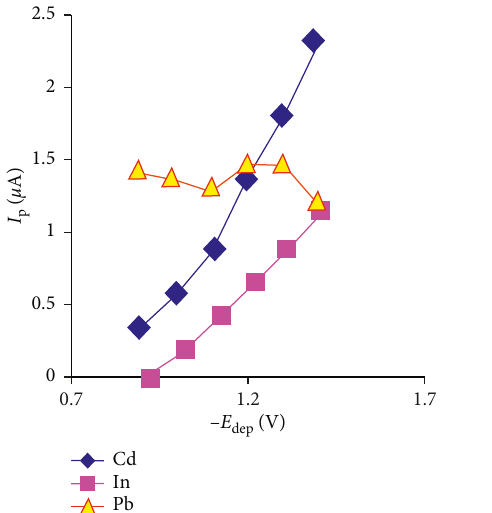
Figure 2: DP-ASV of Cd, In, and Pb at different E Conditions: supporting electrolyte mixture of 0.1 M KI and acetate